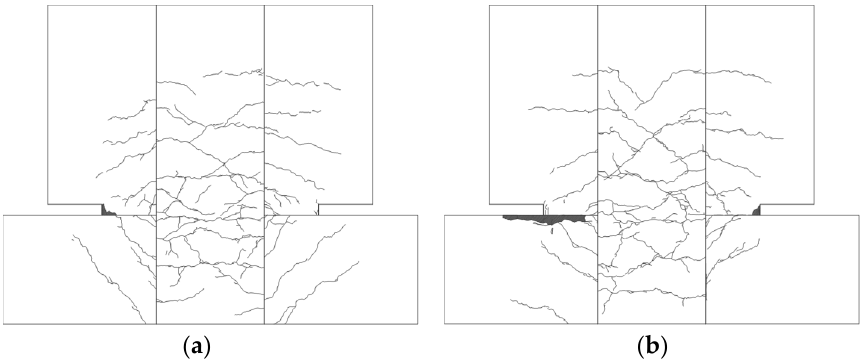
Figure 8. Crack patterns at 1 / 100 drift: ( a ) BSH; ( b )